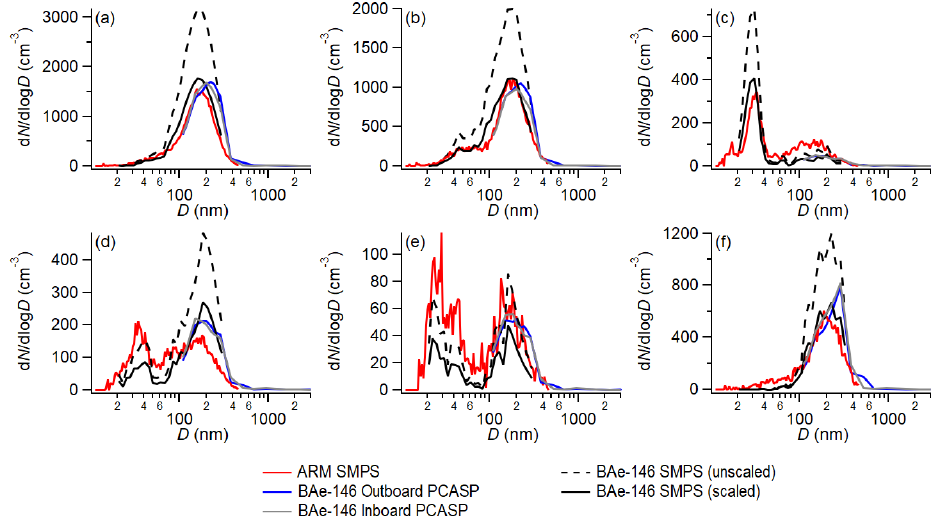
Figure 8. Particle size distribution for six FAAM–LASIC fly-past flight legs for (a) 17 August 2017, (b) 18 August 2017, (c) 22 August 2017, (d) 24 August 2017, (e) 25 August 2017 and (f) 5 September